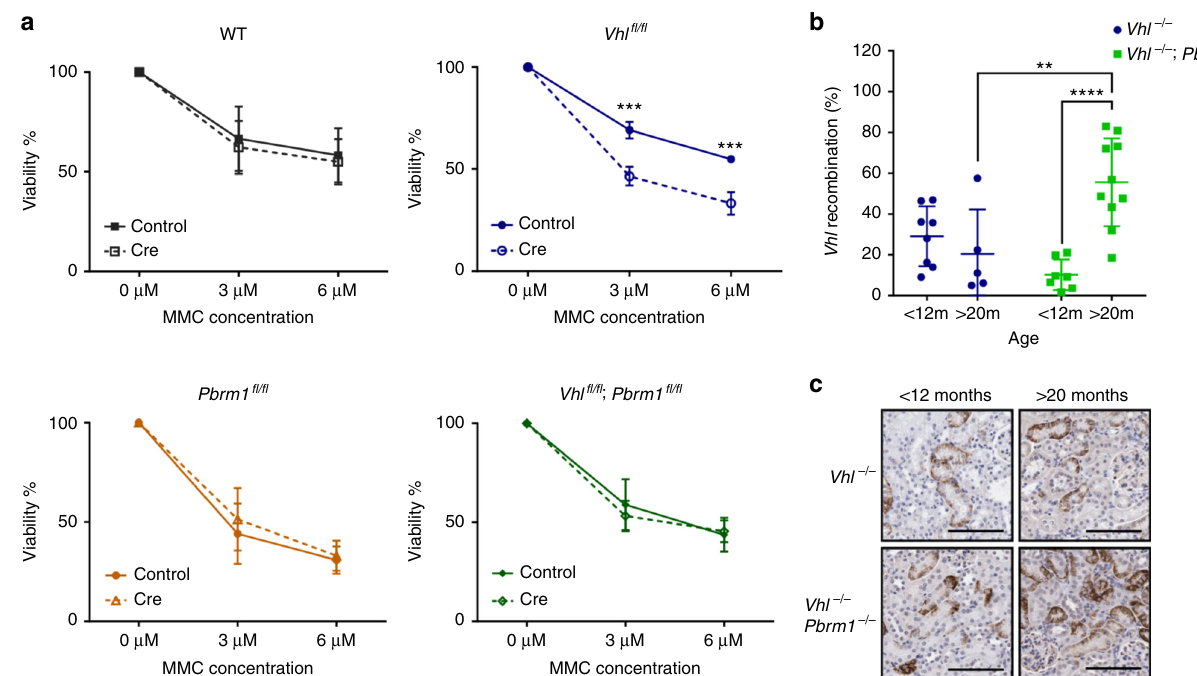
Fig. 4 Combined loss of VHL and PBRM1 improves cellular fi tness. a MEF viability at 6 days following exposure to Mitomycin C ( n (independent experiments) = 4). b qPCR analysis of the recombined Vhl allele present in renal cortical cells of tamoxifen treated Vhl fl / fl ( Vhl − / − ) and Vhl fl / fl ; Pbrm1 fl / fl ( Vhl − / − ; Pbrm1 − / − ), ( Vhl − / − : n = 8 mice < 12 m; 5 mice > 20 m. Vhl − / − ; Pbrm1 − / − : n = 7 < 12 mice, 10 mice > 20 m). c Representative images of CA9 immunohistochemistry of Vhl − / − and Vhl − / − ; Pbrm1 − / − mice at indicated ages. Graphs depict mean ± s.e.m. (error bars). ( a ) Two-way ANOVA, Sidak ’ s correction. ( b ) Two-way ANOVA, Tukey ’ s correction. **** P < 0.0001; *** P < 0.001; ** P <